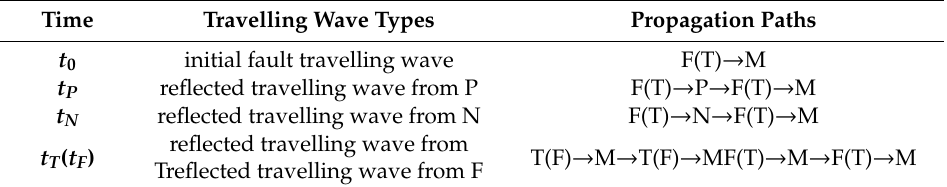
Table 7. Travelling wave types with their reach